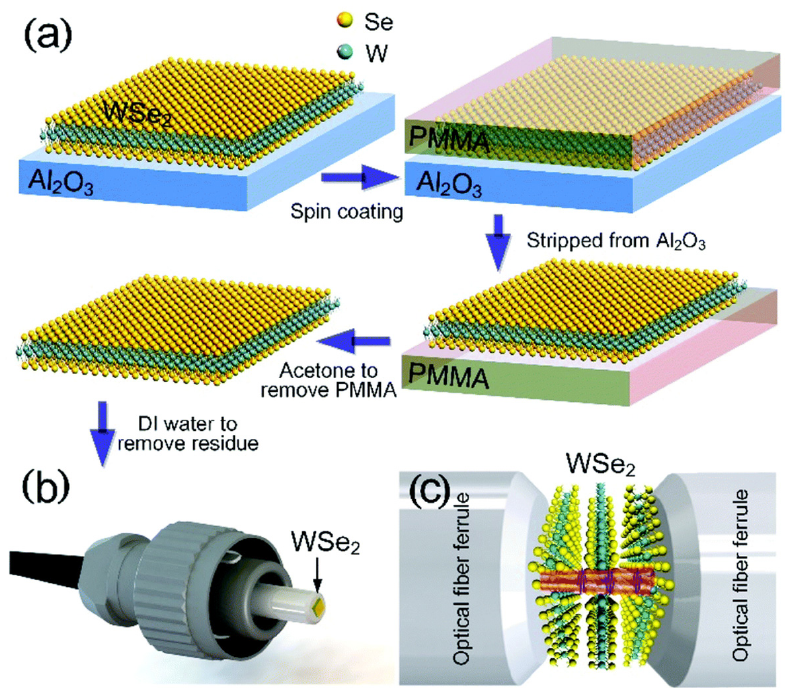
Figure 3. Graphic illustration of the preparation of the WSe 2 -based SA by the CVD method. ( a ) The transfer scheme of WSe 2 films. ( b ) optical image of WSe 2 films transferred onto the fiber ferrule end facet. ( c ) schematic presentation of the few-layer WSe 2 and light interaction. Reproduced with permission [116]. Copyright 2018, RSC.